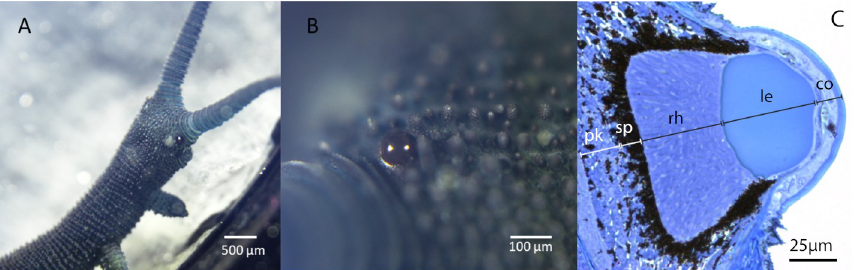
Fig 1. Eye anatomy of velvet worms. The eyes of Euperipatoides rowelli are small ocelli-like structures with a curved cornea, about 100 μ m in diameter in adult animals. Scales: 500 μ m in (A) and 100 μ m in (B). (C) Light microscopic image of a stained semi-thin sections of the eye of Euperipatoides rowelli . Note that there is no space between the lens and the rhabdoms in the retina (photoreceptor volume). Cornea (co), lens (le), rhabdom layer/photoreceptor volume (rh), layer of screening pigment layer (sp), perikaryal layer (pk), adopted from [9].